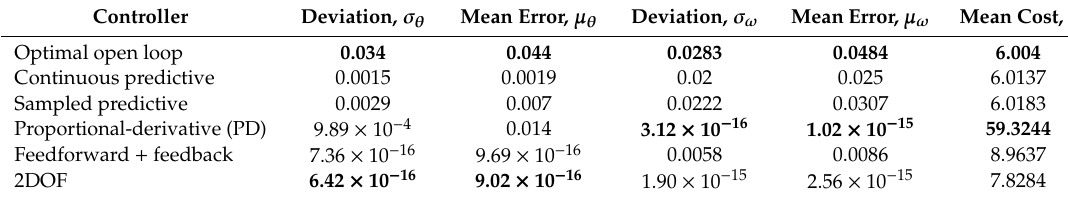
Table 2. Statistical Analysis or mis-modeled plant 1